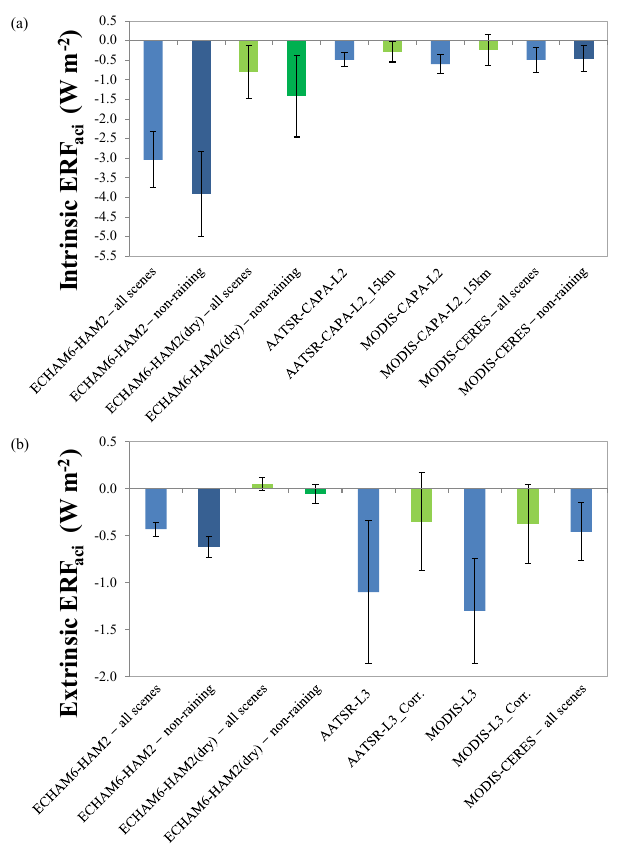
Figure 9. Estimates of (a) intrinsic and (b) extrinsic effective radia- tive forcing due to aerosol–cloud interactions (ERF aci ) of low liquid clouds between 60 ◦ N and 60 ◦ S. For ECHAM6-HAM2, separate estimates for all scenes and non-raining scenes (<0.5mmday − 1 ) as well as with or without aerosol water uptake (dry aerosol) are shown. For AATSR–CAPA and MODIS–CAPA estimates with all aerosol particles (L2/L3) and excluding near-cloud aerosol parti- cles (L2_15km/L3_Corr.) are shown. Only values averaged over global oceans are shown. The AATSR–CAPA and MODIS–CAPA forcing data are from Christensen et al. (2017). Note that the values for MODIS–CAPA/MODIS-L3/MODIS-L3_Corr. are com- puted from 3 months’ worth of data for June, July and August 2008 only. The MODIS–CERES forcing data are from Chen et al. (2014). The uncertainty is based on the standard error of the linear regres- sion. Light blue bars are used for all scenes with aerosol water up- take or including near-cloud aerosol particles. Green bars indicate removal of aerosol water or near-cloud aerosol particles. Dark bar colours are used for non-raining